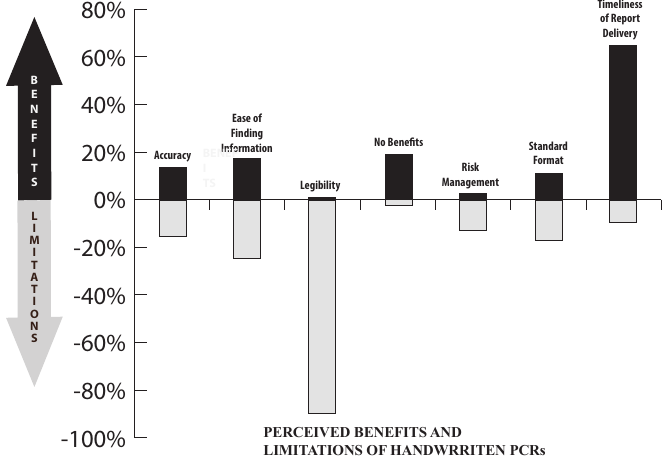
Figure 4 . Respondents’ report of perceived benefits and limitations of handwritten patient care reports.